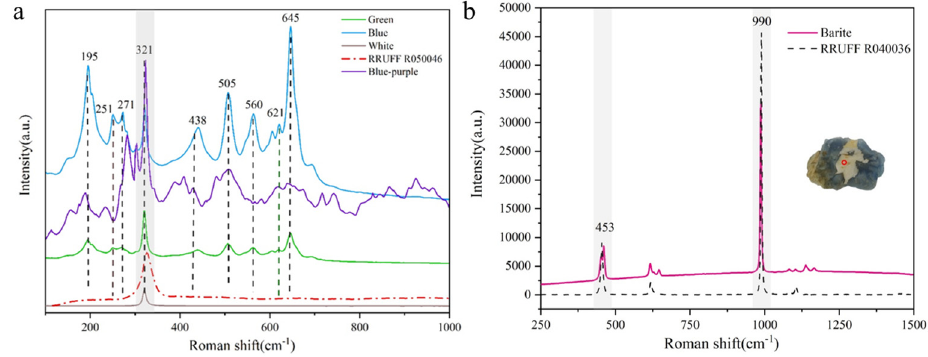
Figure 5. ( a ) Raman spectra of all color fluorite samples; ( b ) Raman spectra of barite in light blue- purple samples.